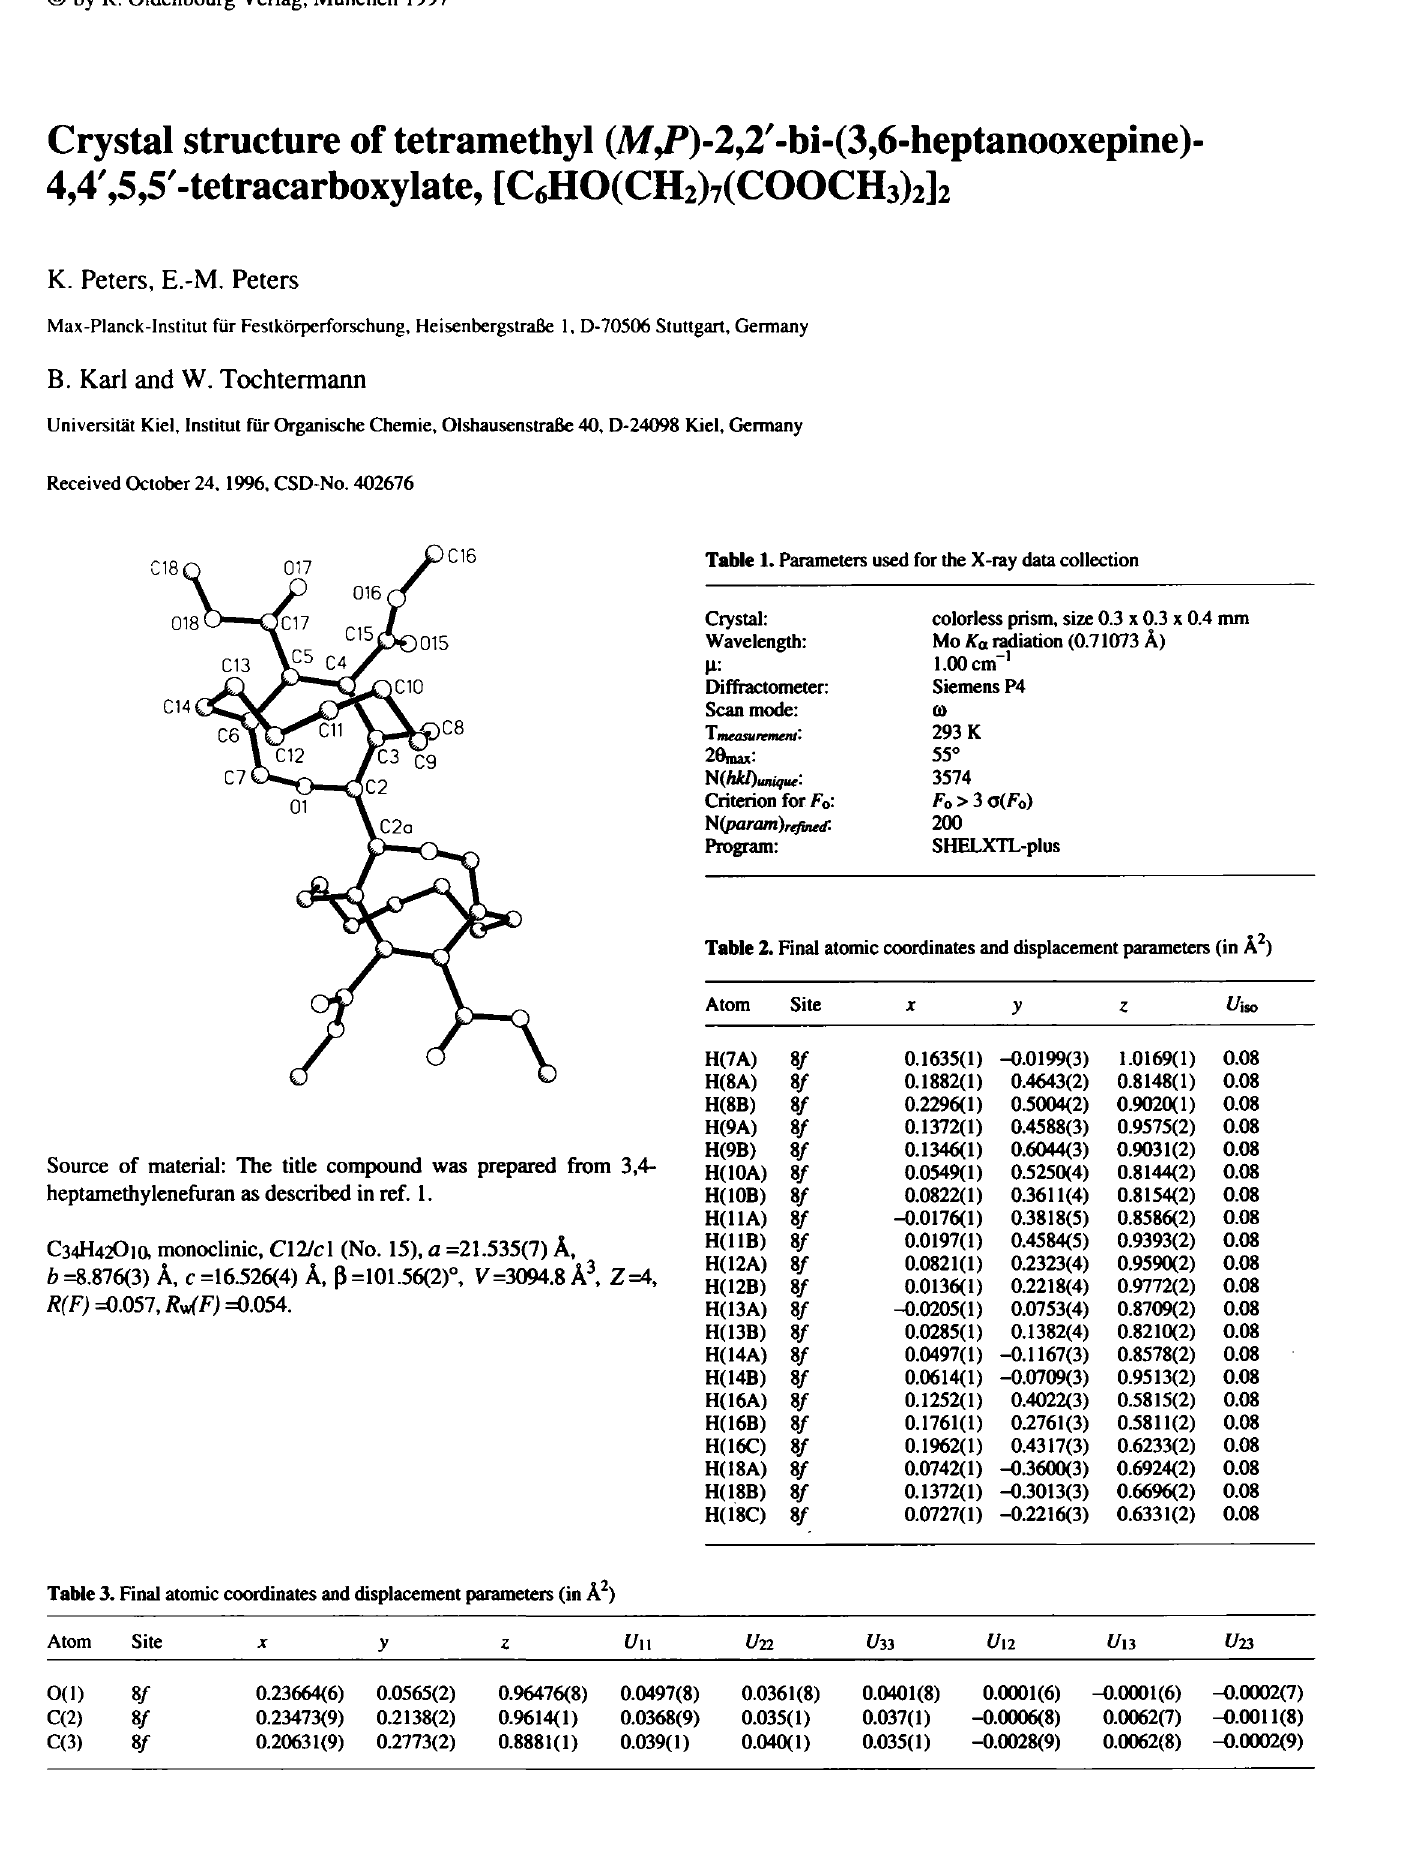
Table 3. Final atomic coordinates and displacement parameters (in À 2